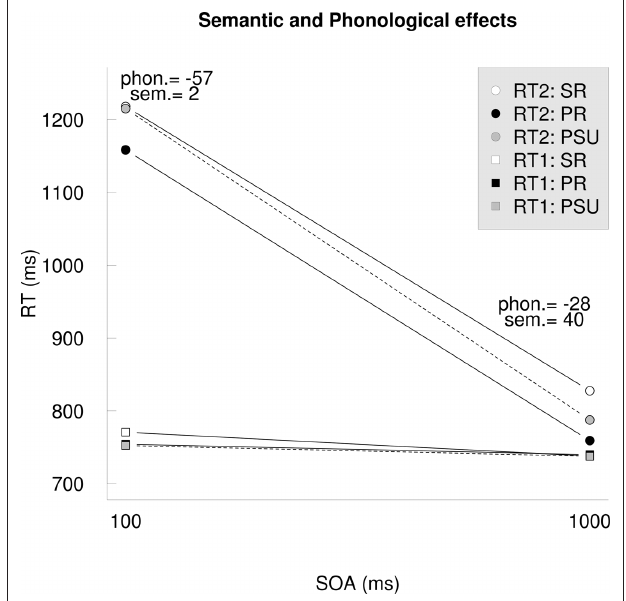
Figure 3 | Mean reaction times in experiment 2, plotted separately for tone discrimination (rT1) and picture naming latencies (rT2), as a function of distractor relatedness, and SOA. PR = picture and word phonologically related; SR = picture and word semantically unrelated; P-SU = picture and word phonologically and semantically unrelated. Numerical values indicate the magnitude of the semantic interference effect (positive values) and of the phonological facilitation effect